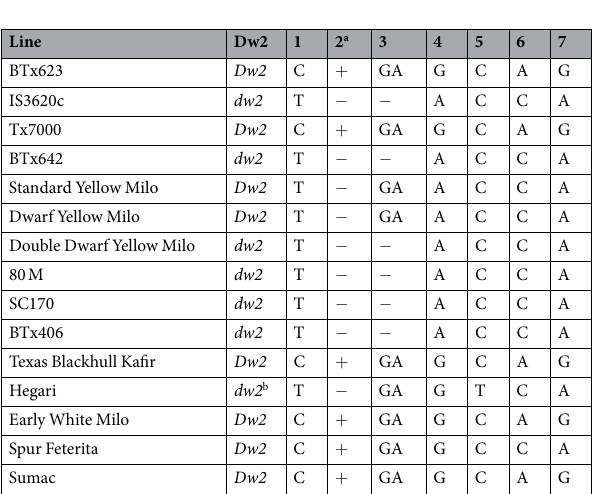
Table 4. Selected Genotypes Scored at the Polymorphisms Listed in Table 3. a The plus sign indicates that the genotype lacks the deletion, while the minus sign indicates that the genotype has the deletion. b Hegari is listed as recessive dw2 by Quinby and Karper 7 ; however, a QTL mapping F 2 population of Hegari and 80 M segregated for Dw2 , with the increase in length coming from Hegari 16